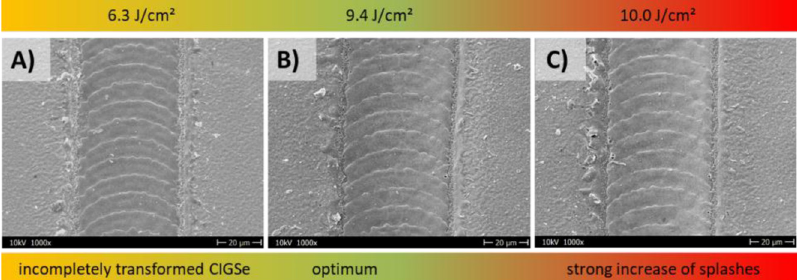
Fig. 8. Comparison of SEM images of P2 scribe lines patterned with three characteristic fl uences: (A) 6.3 J/cm 2 (incompletely transformed CIGSe), (B) 9.4 J/cm 2 (optimal scribe line properties), and (C) 10.0J/cm 2 (strong formation of splashes). The color bars indicate the respective patterning regimes and the chosen patterning fl uences. The magni fi cation of the images is 1000 (cid:1) , the excitation voltage is 10kV.